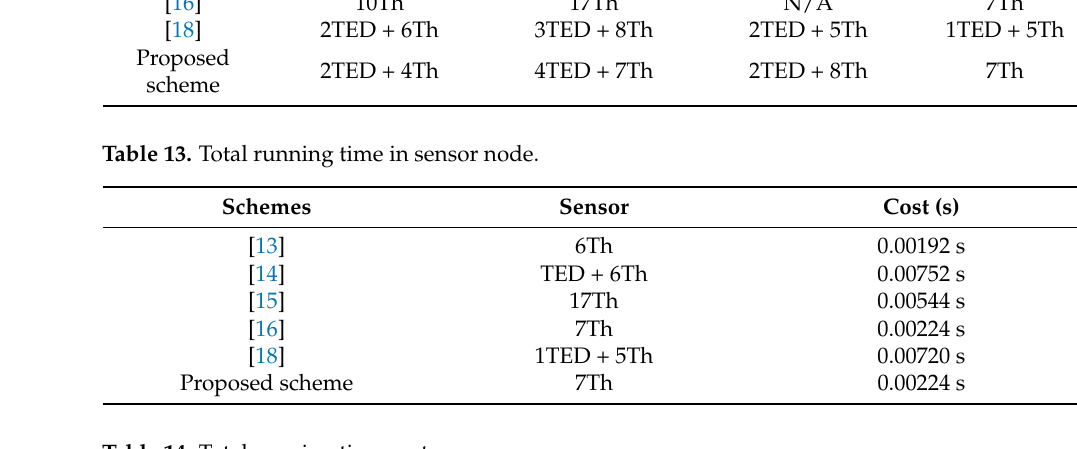
Table 14. Total running time